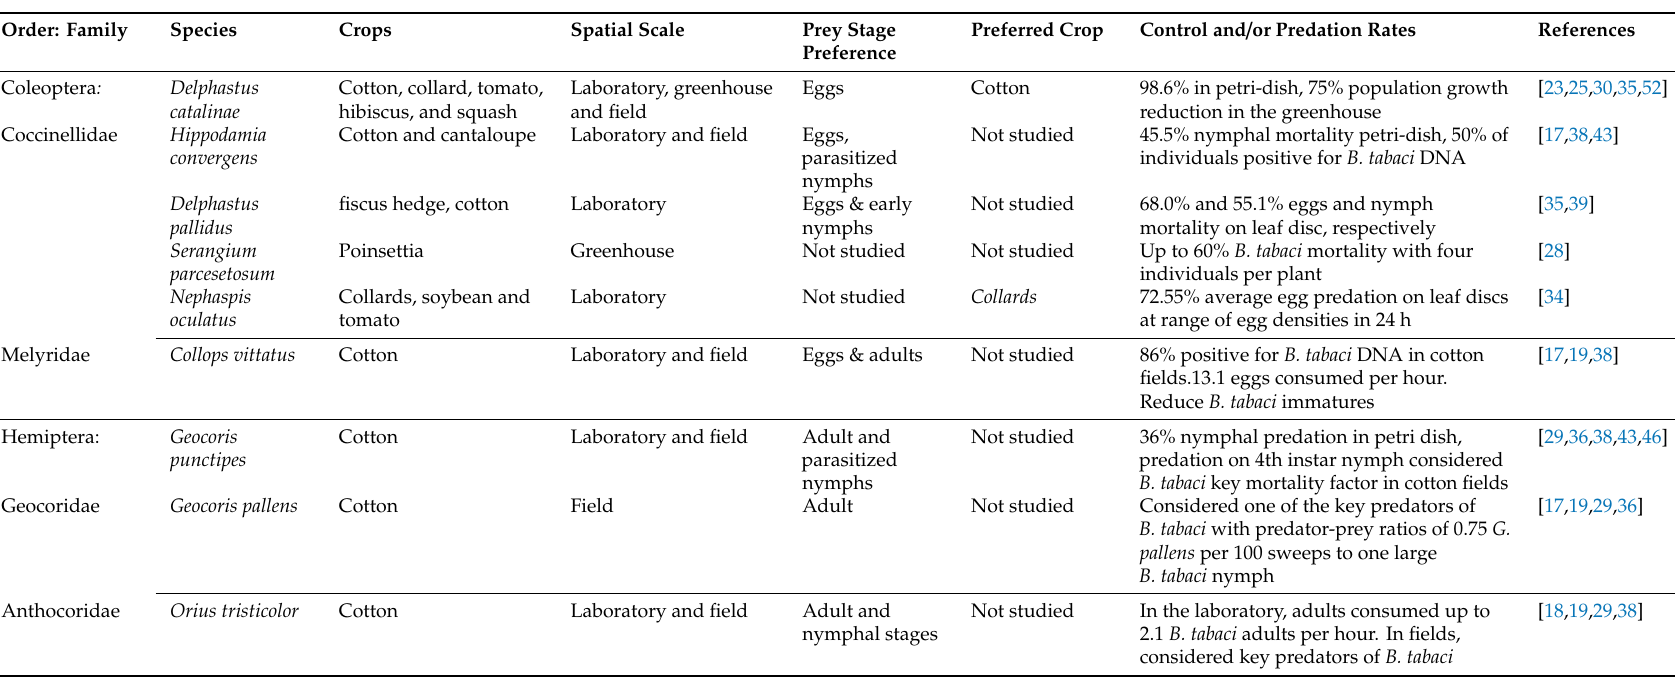
Table 2. Summary of Bemisia tabaci generalist predators in the United States, along with information regarding the spatial scale of the study (e.g., field, laboratory or greenhouse), the levels of reported contribution to B. tabaci control under the various